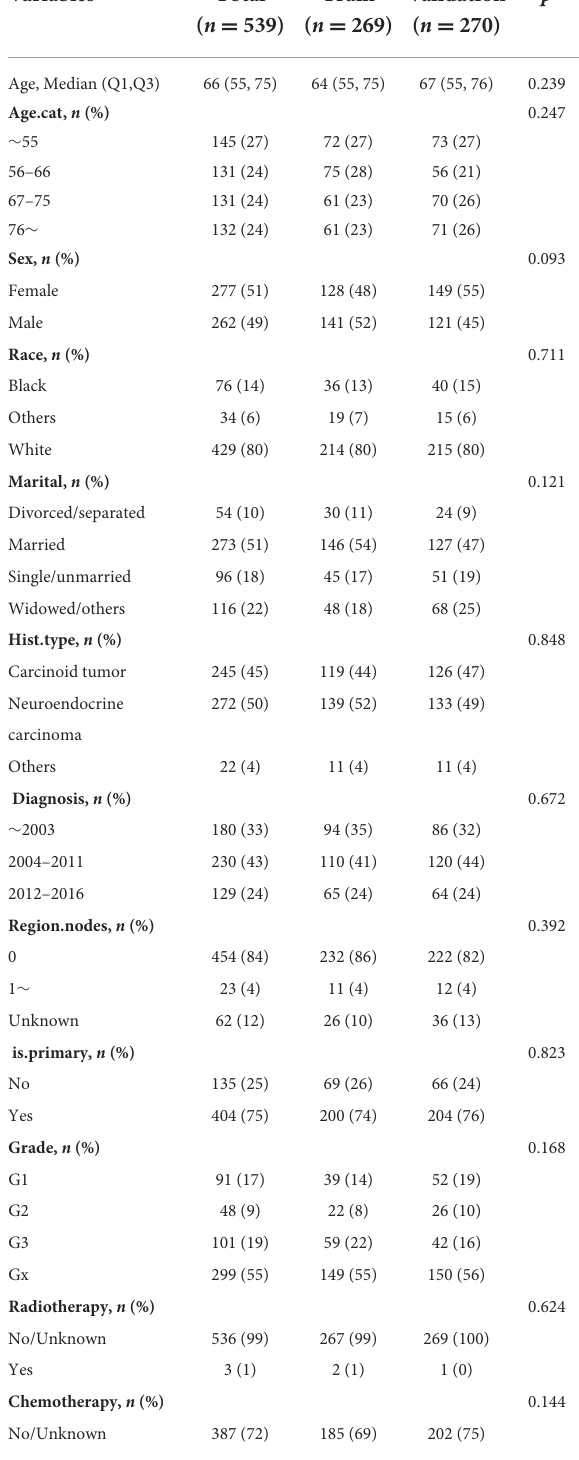
TABLE 1 The basic characteristics of PHNET patients in training set and validation